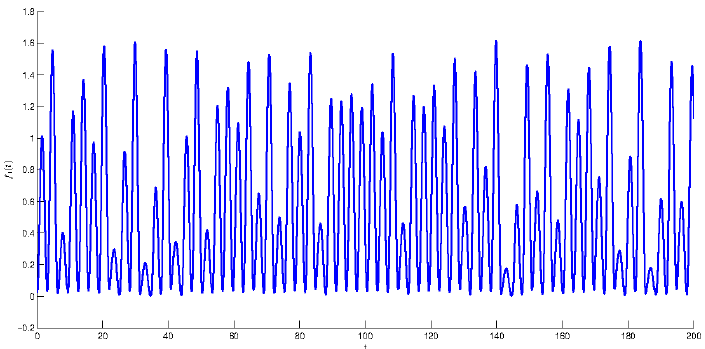
Figure 3. The graph of compartmental periodic unpredictable function f 3 ( t ) . The degree of periodicity ∇ =